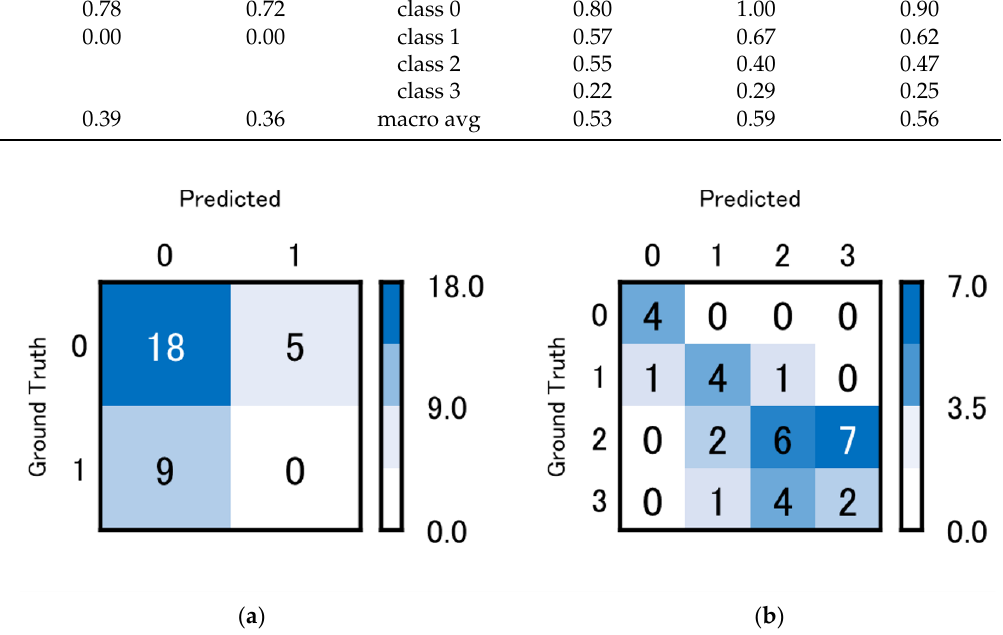
Figure 4. Confusion matrix for training model: ( a ) 2-class classification result (disease); ( b ) results of 4-class classification (severity).